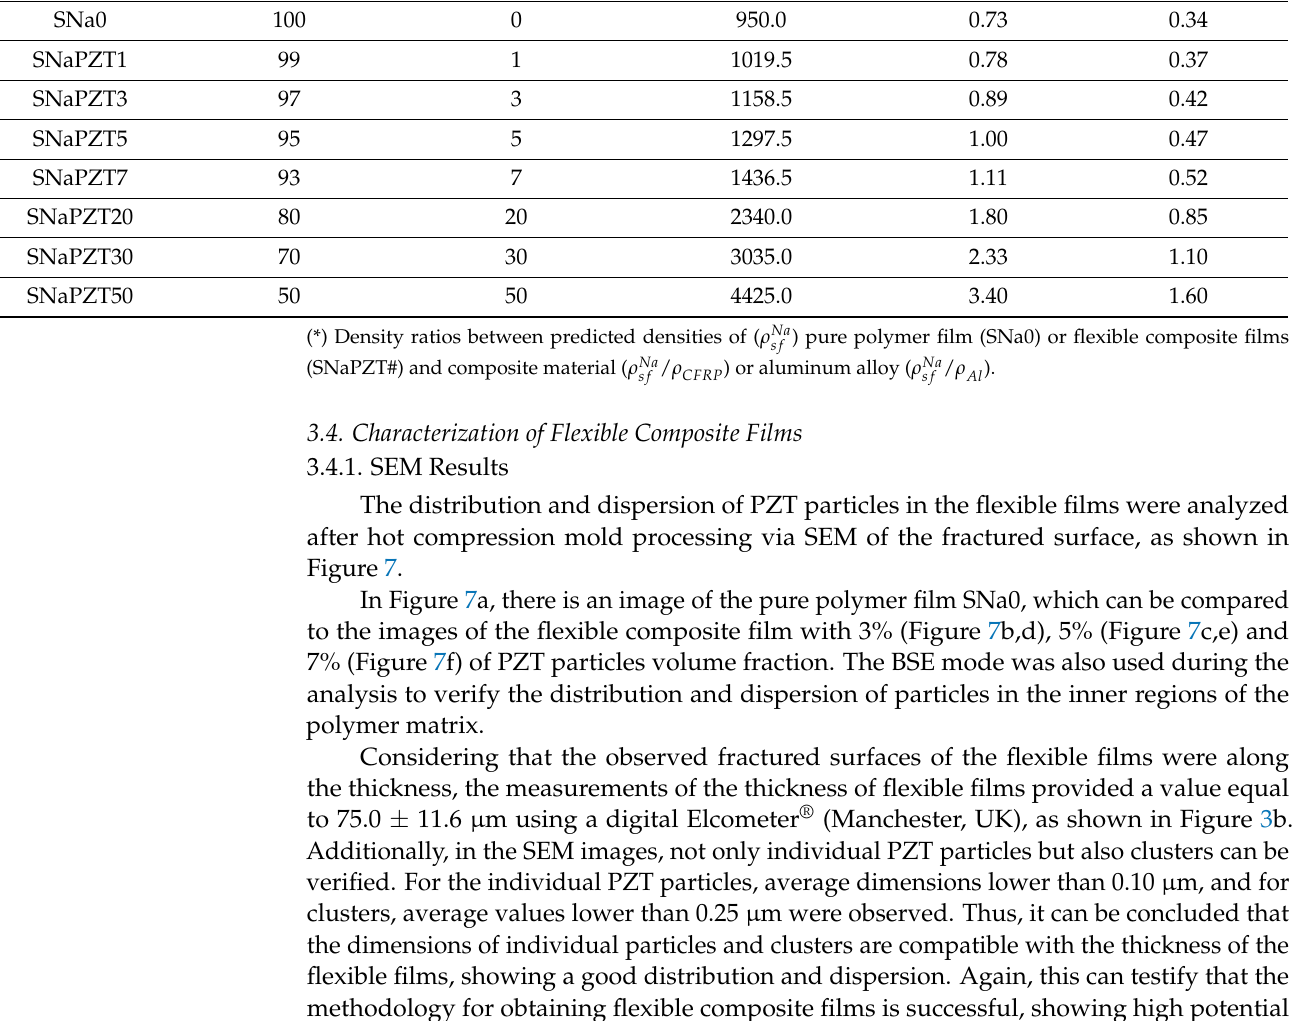
Table 1. Density of flexible pure polymer film SNa0 and flexible composite films SNaPZT#, where # is equal to 1, 3, 5, 7, 20, 30 and 50% of PZT, represented by ρ Na